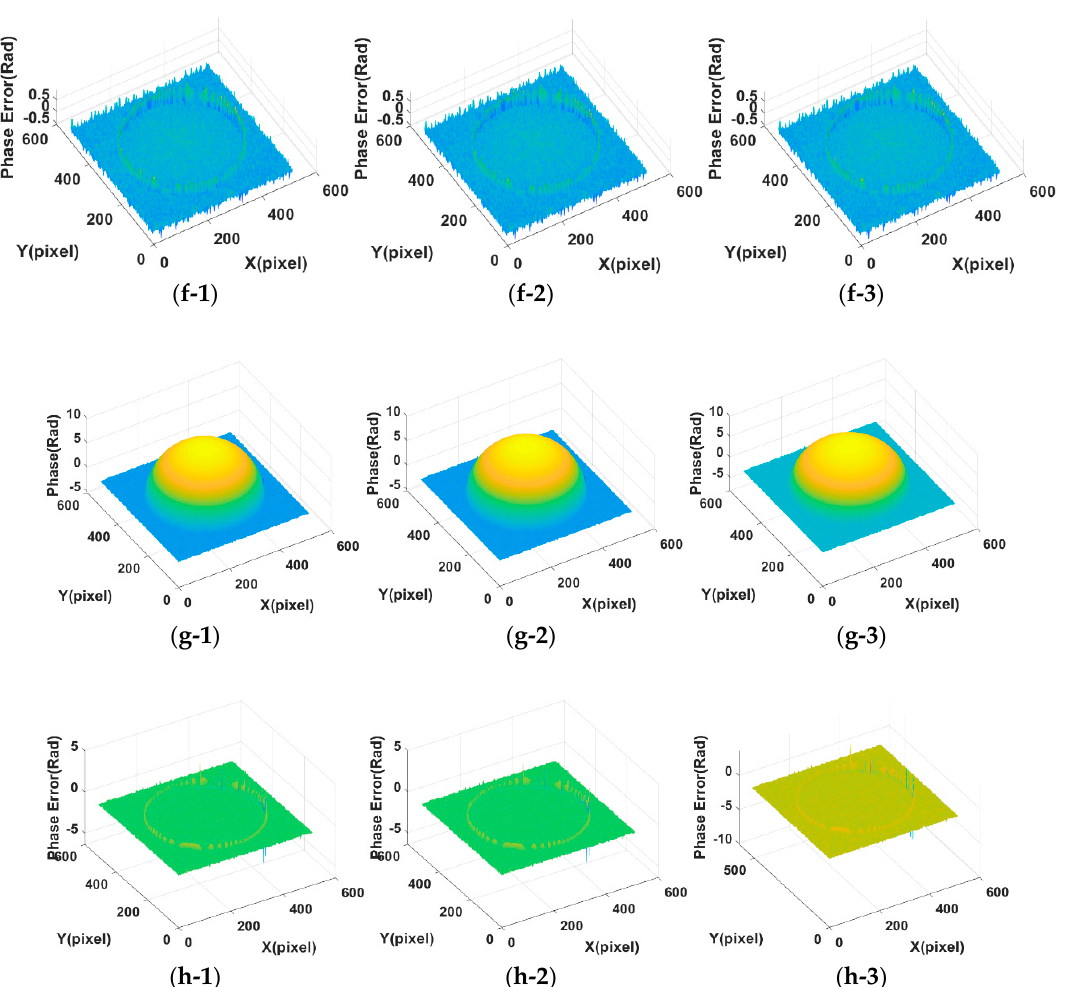
Figure 6. The retrieved phase and phase error for Figure 1 by Fourier transform method under optimal CrossUV, SE and SSIMV. ( a-1 ) Phase under optimal CrossUV for Figure 1a; ( a-2 ) Phase under optimal SE for Figure 1a; ( a-3 ) Phase under optimal SSIMV for Figure 1a; ( b-1 ) Phase error under optimal CrossUV for Figure 1a; ( b-2 ) Phase error under optimal SE for Figure 1a; ( b-3 ) Phase error under optimal SSIMV for Figure 1a; ( c-1 ) Phase under optimal CrossUV for Figure 1b; ( c-2 ) Phase under optimal SE for Figure 1b; ( c-3 ) Phase under optimal SSIMV for Figure 1b; ( d-1 ) Phase error under optimal CrossUV for Figure 1b; ( d-2 ) Phase error under optimal SE for Figure 1b; ( d-3 ) Phase error under optimal SSIMV for Figure 1b; ( e-1 ) Phase under optimal CrossUV for Figure 1c; ( e-2 ) Phase under optimal SE for Figure 1c; ( e-3 ) Phase under optimal SSIMV for Figure 1c; ( f-1 ) Phase error under optimal CrossUV for Figure 1c; ( f-2 ) Phase error under optimal SE for Figure 1c; ( f-3 ) Phase error under optimal SSIMV for Figure 1c; ( g-1 ) Phase under optimal CrossUV for Figure 1d; ( g-2 ) Phase under optimal SE for Figure 1d; ( g-3 ) Phase under optimal SSIMV for Figure 1d; ( h-1 ) Phase error under optimal CrossUV for Figure 1d; ( h-2 ) Phase error under optimal SE for Figure 1d; ( h-3 ) Phase error under optimal SSIMV for Figure 1d.